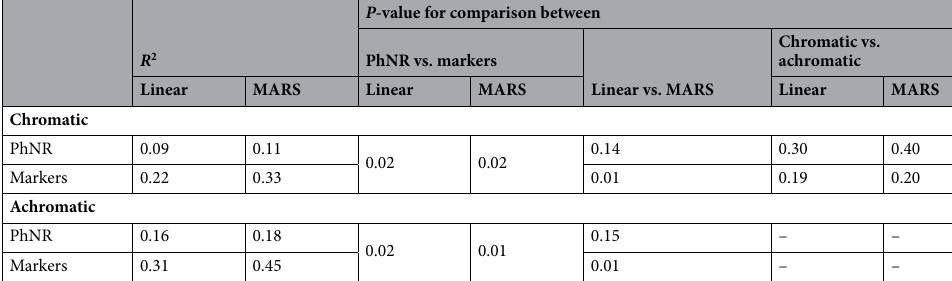
P -value for comparison between PhNR vs.